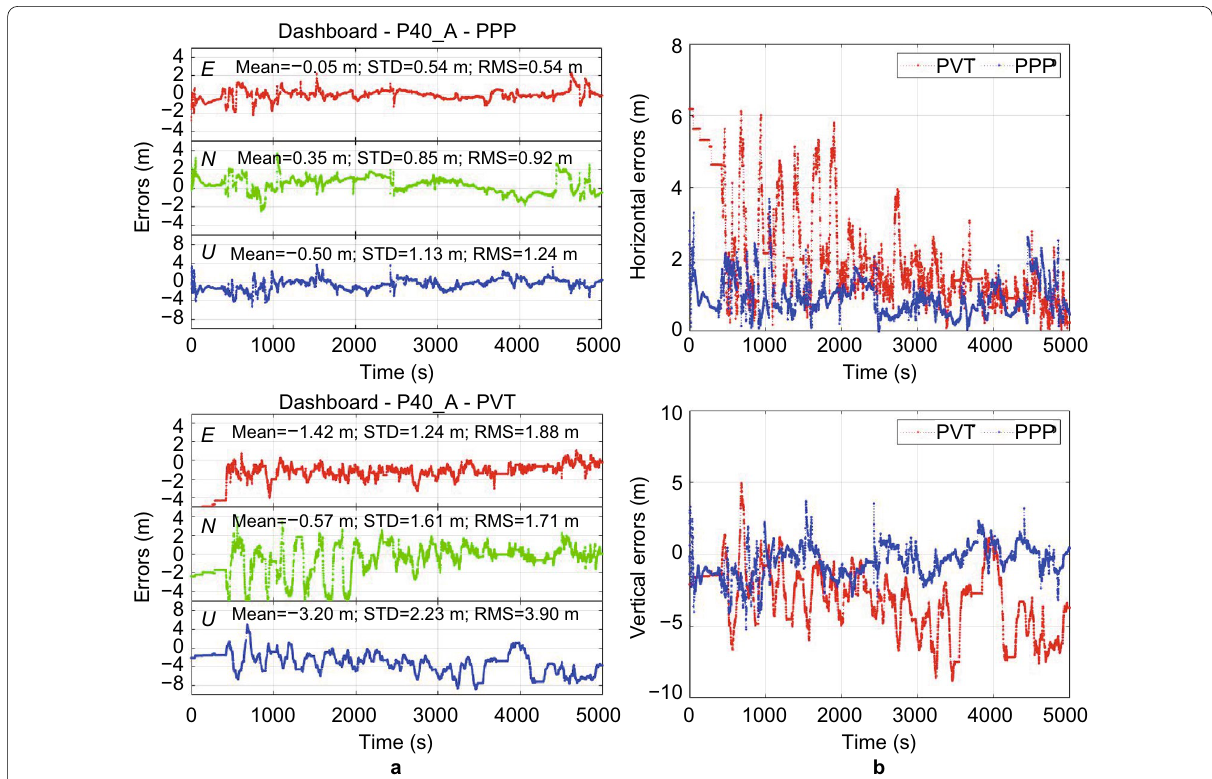
Fig. 13 The time series of the positioning errors of PPP and PVT results in a the E , N , and U components and b the horizontal and vertical directions for the P40_A smartphone in the dashboard mode test